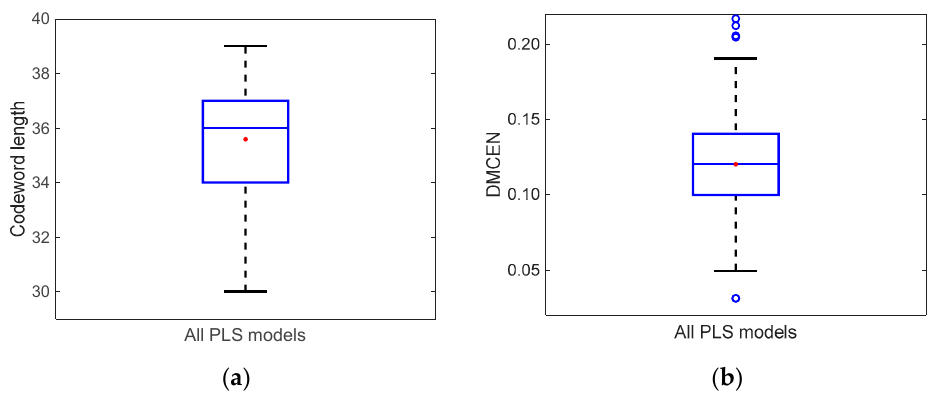
Figure 4. Some characteristics of the 280 repetitions made in the optimisation step. ( a ) Codeword length of ECOC matrices. ( b ) DMCEN values for PLS models built with these ECOC matrices.